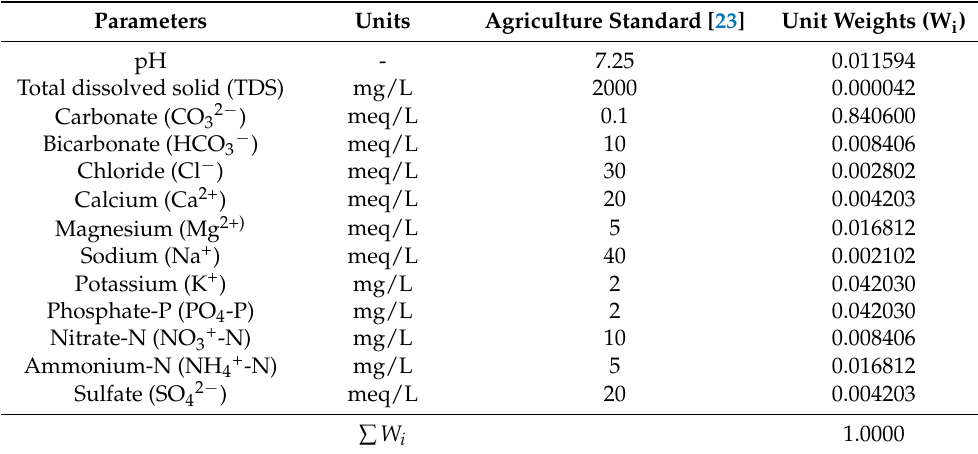
Table 5. The standard water-quality guidelines for irrigation and unit weights for parameters.